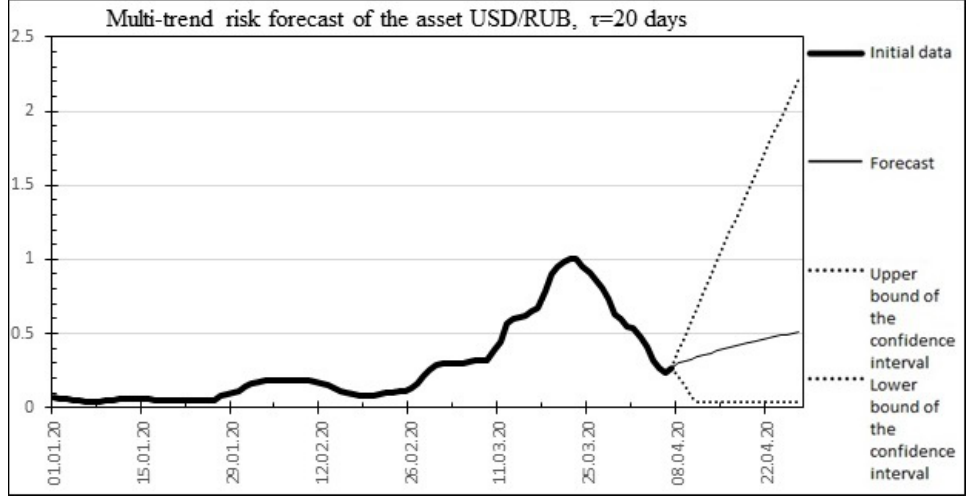
Figure 9. Multitrend risk forecast.